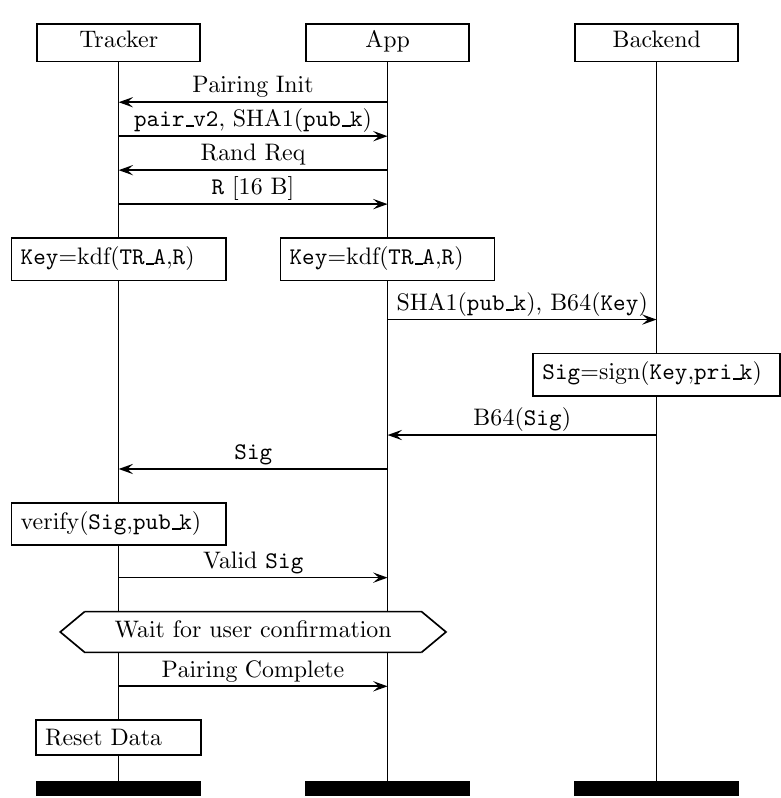
Figure 4: Xiaomi Pairing v2. The app starts the protocol by sending a Pairing Init message. The tracker sends back pair_v2 and a public key digest (SHA1( pub_k )). Then the app requests a random number, and the tracker replies with R , which is 16 bytes long. Both devices run a custom key derivation function ( kdf ) to compute Key from R (key seed) and the Bluetooth address of the tracker ( TR_A) . Then, the app sends SHA1( pub_k ) and Key base64-encoded to the backend. The backend computes a signature ( Sig ) of Key with its private key and sends Sig base64-encoded to the app. The app presents Sig to the tracker, which verifies it and sends back a confirmation message. Then, the tracker shows the user a pairing confirmation message, and if the user accepts, pairing is completed, and the tracker resets its